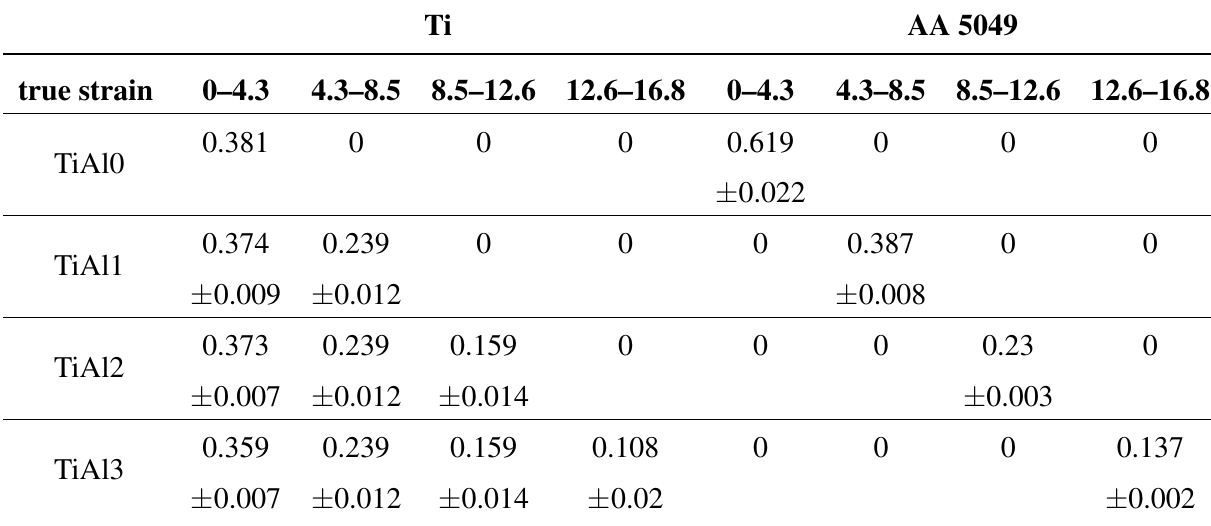
Table 2. Volume fractions of the different deformed parts of the composites, TiAl0, TiAl1, TiAl2 and TiAl3. Data is derived by mass density measurements and quantitative analysis of the phase arrangements. For errors, please refer to the error calculation in the